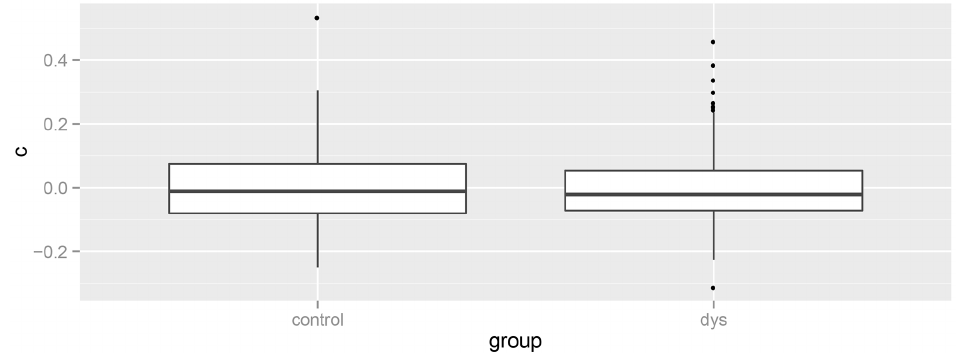
Figure 2. Boxplots of the subject-specific deviations of the response criteria, showing that there was no more variability in c1 scores of the students with dyslexia than in those of the age matched